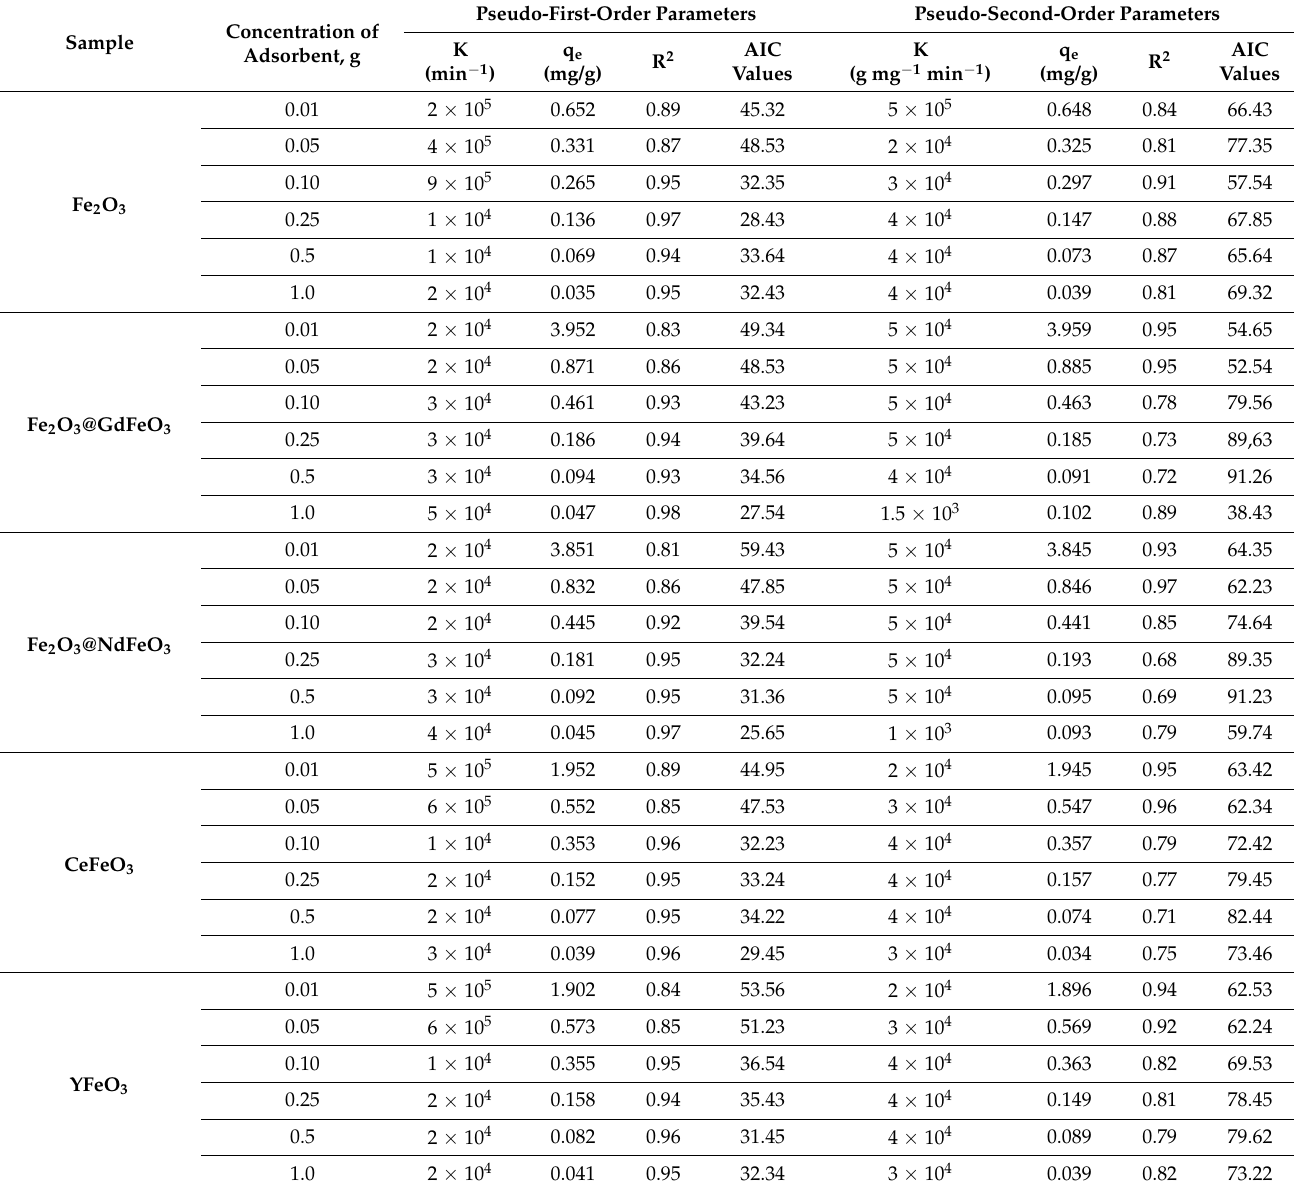
Table 1. Estimated parameters of pseudo-first- and pseudo-second-order kinetic models for man- ganese adsorption using various